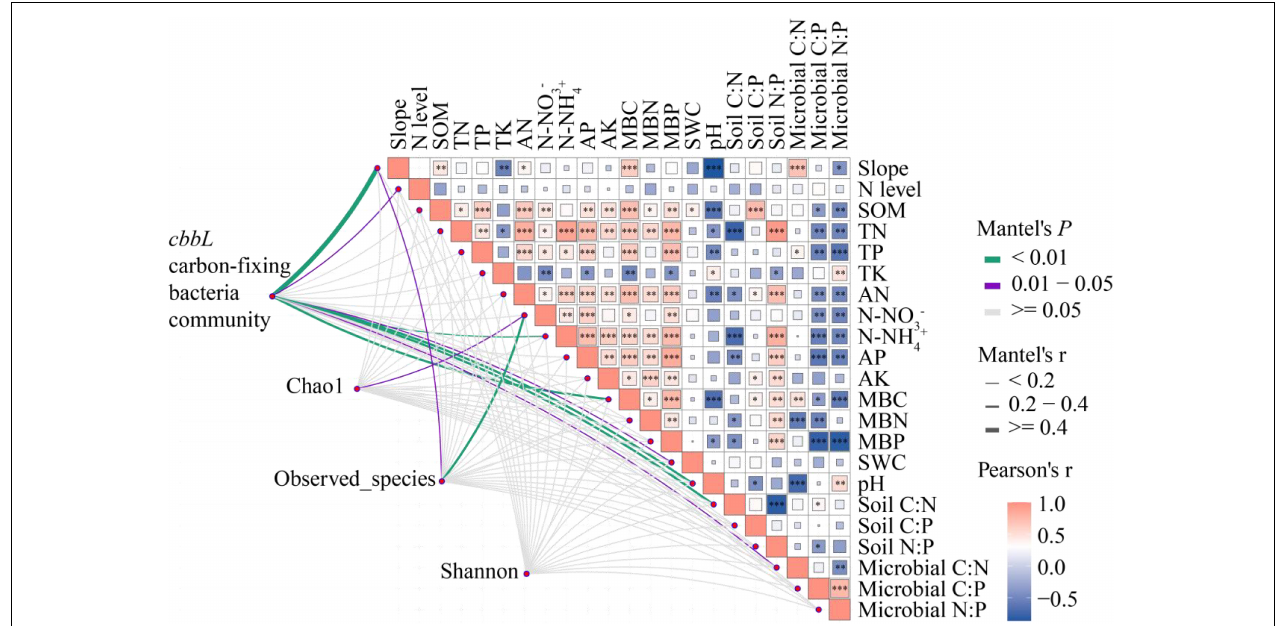
FIGURE 7 | Correlation of carbon-fixing microbial community and diversity with slope, nitrogen addition level, soil physicochemical properties, stoichiometric proportion, and microbial biomass. Mantel edge width corresponds to Mantel r value, and edge color indicates statistical significance. The color gradient of Pearson correlation coefficient r represents the paired correlation of variables. 27 ◦ for steep slope and 8 ◦ for gentle slope. N addition levels include CK: 0 g N · m − 2 , LN: 2 g N · m − 2 , MN: 5 g N · m − 2 , and HN: 10 g N · m − 2 . Carbon-fixing microbial community includes 28 bacteria genera with significant differences among different slopes. ∗ indicates 0.01 < P < 0.05, ∗∗ indicates P < 0.01, and ∗∗∗ indicates P <